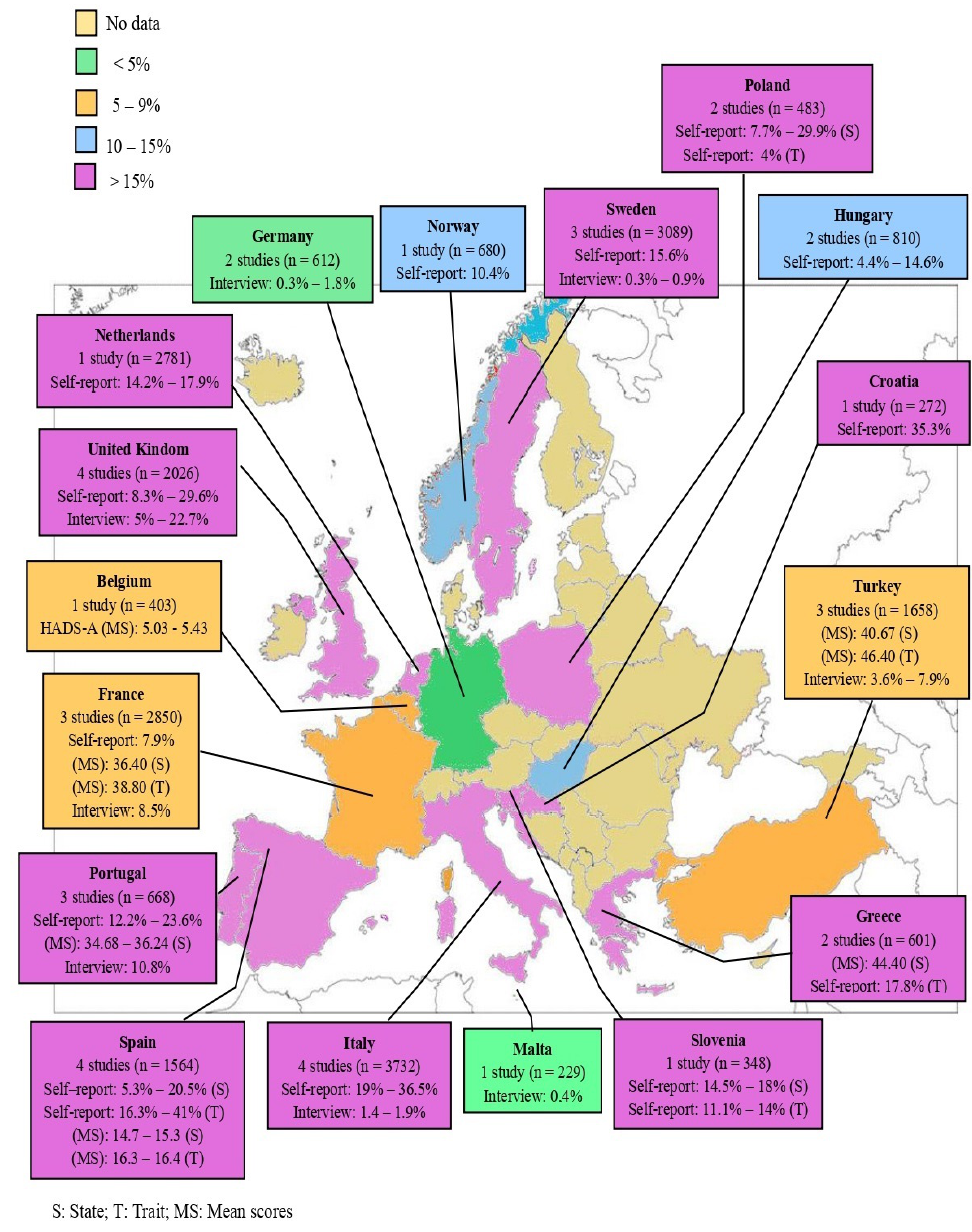
Figure 2. Distribution of prenatal anxiety across European countries. Table 1. Prevalence of anxiety during